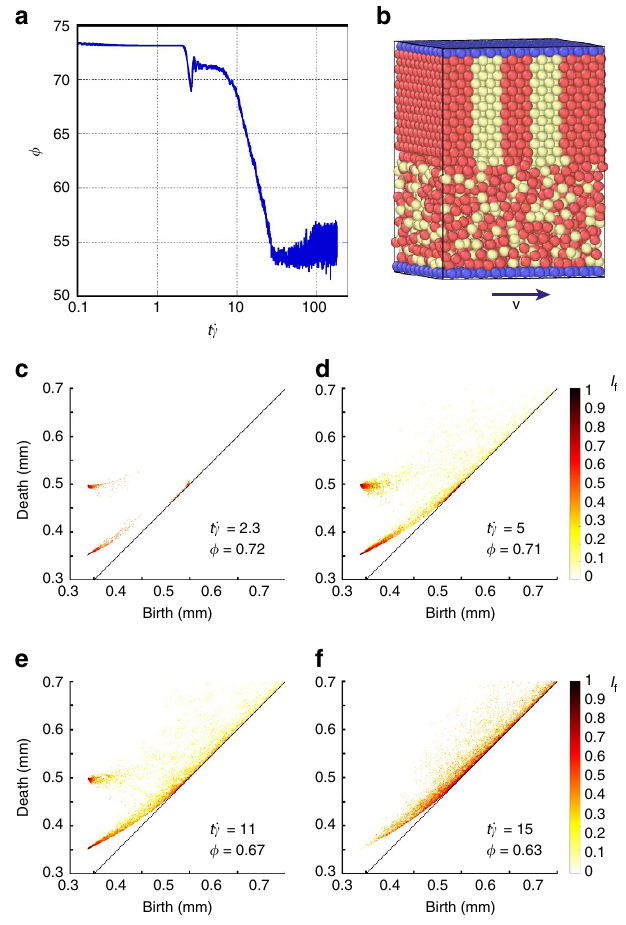
Figure 7 | Numerical simulation of the dynamics of the order–disorder transition of a bead packing under shear. ( a ) Packing density versus time (expressed in inverse shear rate units). ( b ) Snapshot of the numerically generated packings as it gets disordered. ( c – f ) Temporal evolution of PD 2 at different packing density ranging from f ¼ 0.72 to f ¼ 0.63. These diagrams have been computed over 4 6,000